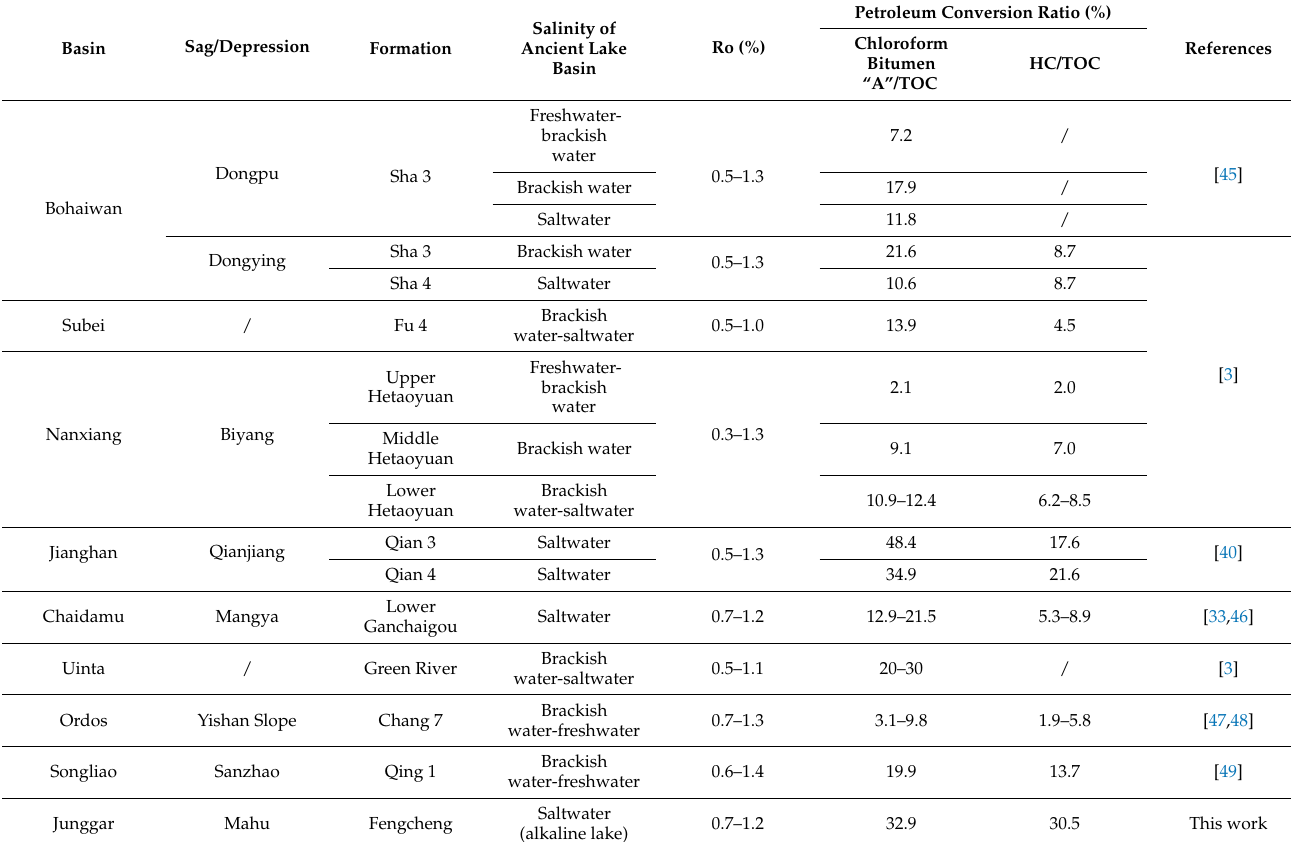
Table 4. Organic matter transformation of source rocks in continental freshwater-brackish lake basins, China.